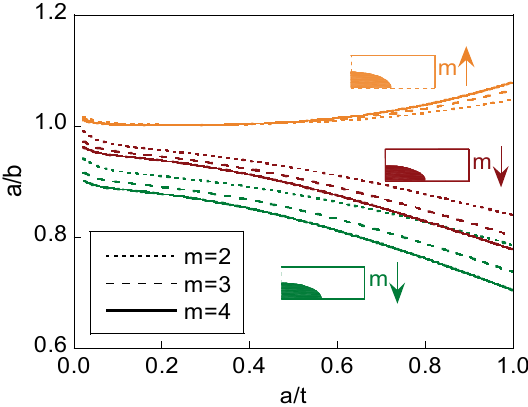
Figure 6. Preferential propagation paths. (The arrows indicate the direction in which the curves are moved with the increase of the Paris m exponent).